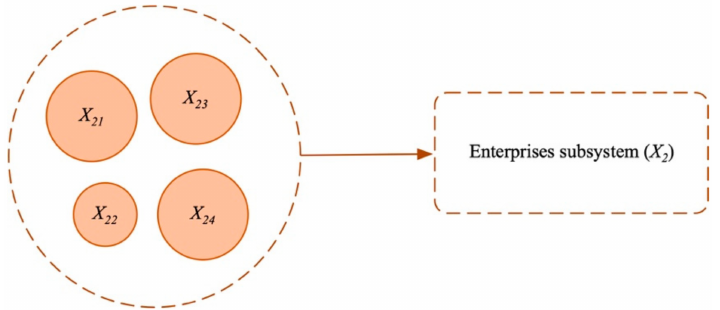
Figure 5. Indicators interaction in the enterprises